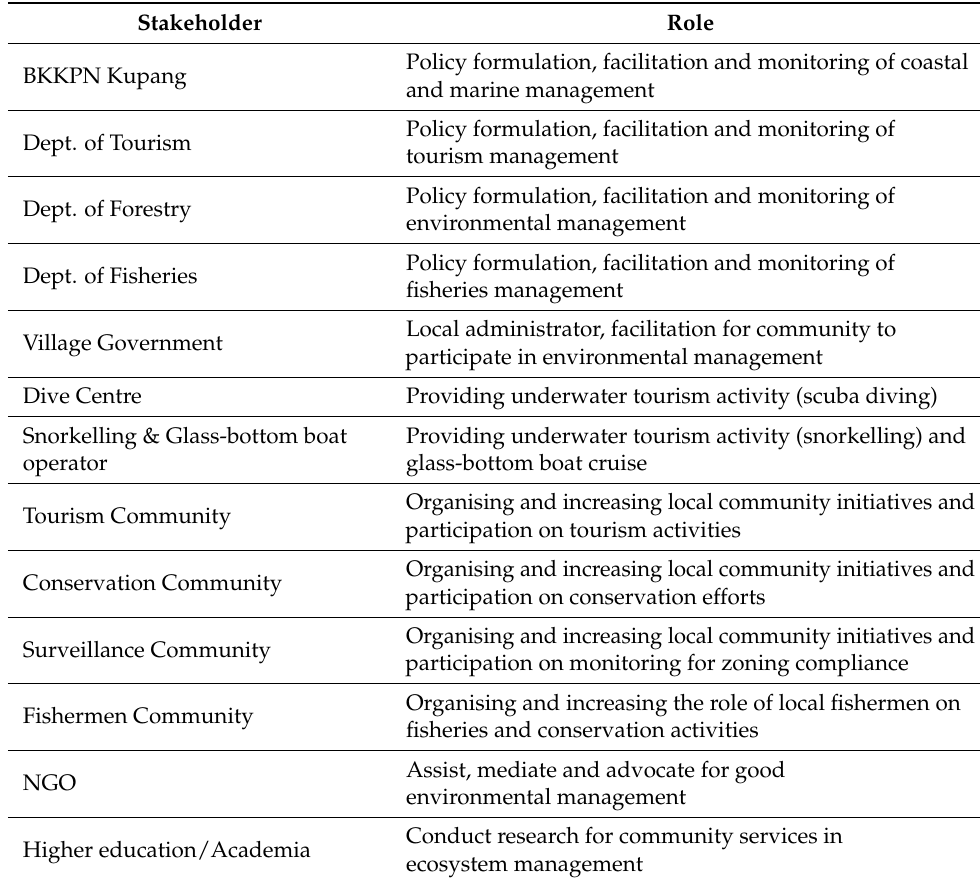
Table 2. Role description of stakeholder groups for management of the coral reef ecosystem in the GMMTP